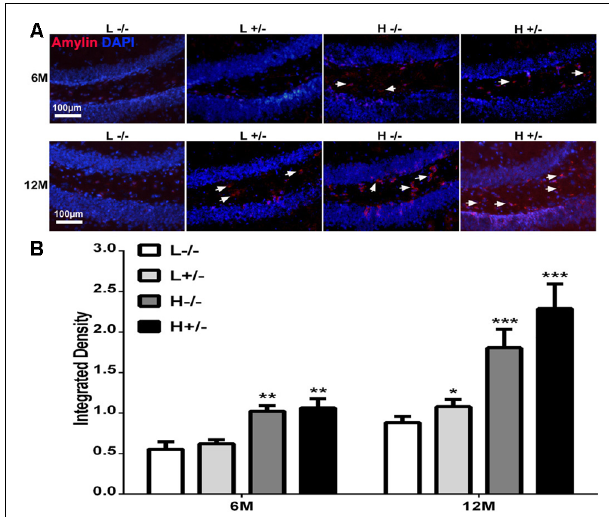
FIGURE 2 | Amylin content in the hippocampi of hIAPP − / − and hIAPP + / − mice increased under a high-fat diet. (A) Representative images of amylin-positive particles in the DG of the hippocampus. White arrows indicate positive staining with the amylin antibody, and blue staining indicates the nucleus. (B) Six sections per mouse were stained, and positive particles were analyzed by using ImageJ software. L − / − denotes hIAPP − / − mice on a low-fat diet; L + / − denotes hIAPP + / − mice on a low-fat diet; H − / − denotes hIAPP − / − mice on a high-fat diet; H + / − denotes hIAPP + / − mice on a high-fat diet. n = 6, ∗ p < 0.05, ∗∗ p < 0.01, ∗∗∗ p < 0.001 compared with the L − / −